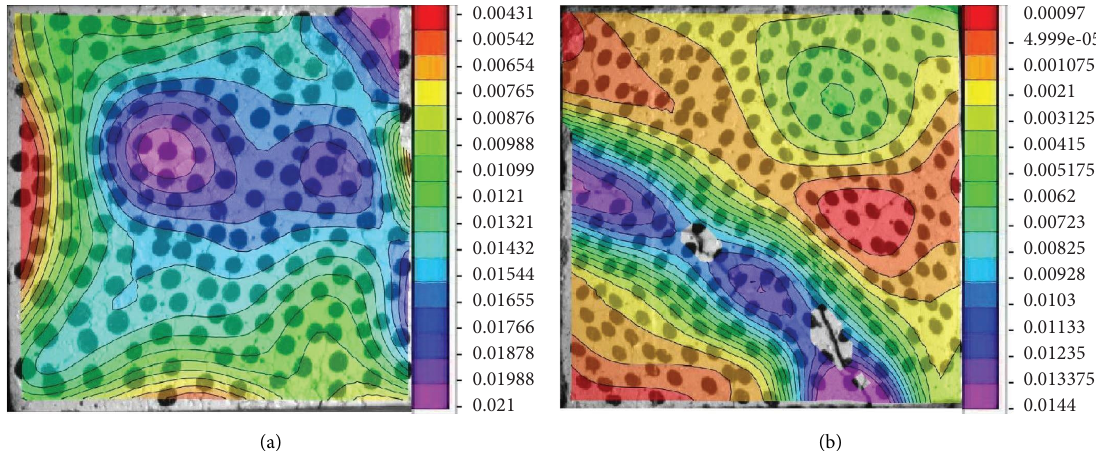
Figure 18: Vertical strain cloud diagram of specimen in water environment (after 5 freezing-thawing cycles) for (a) glass fber-reinforced cemented soil and (b) cemented soil without fbers.